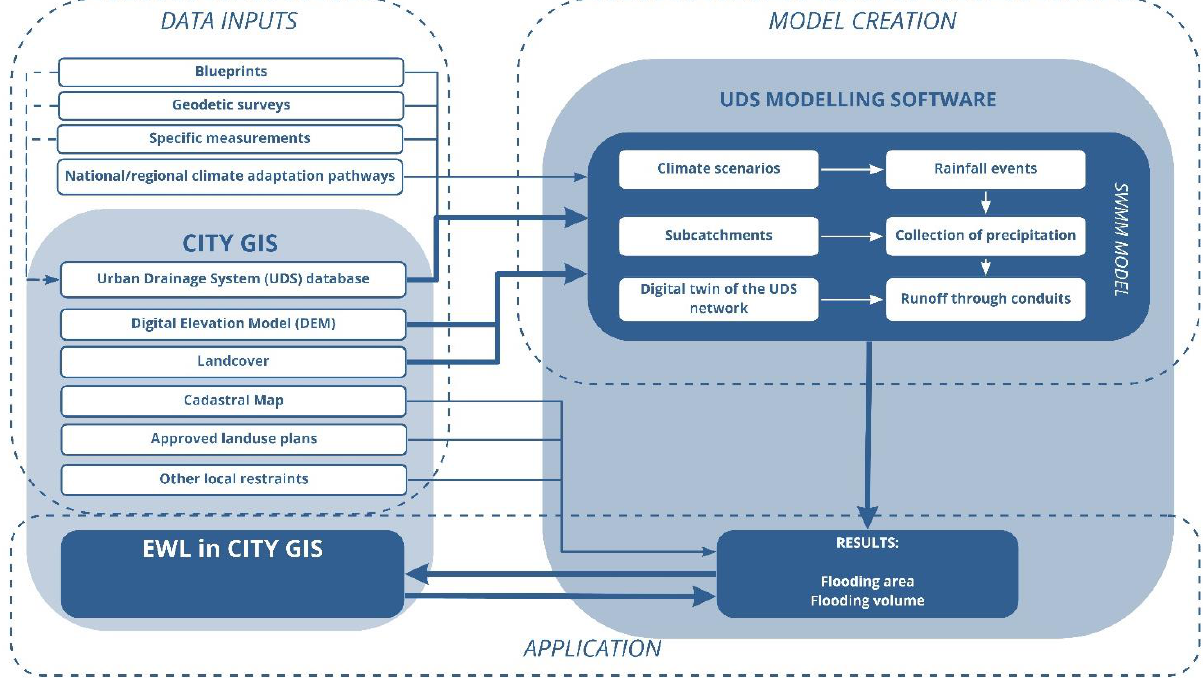
Figure 1. Layout of the integrated planning layer.